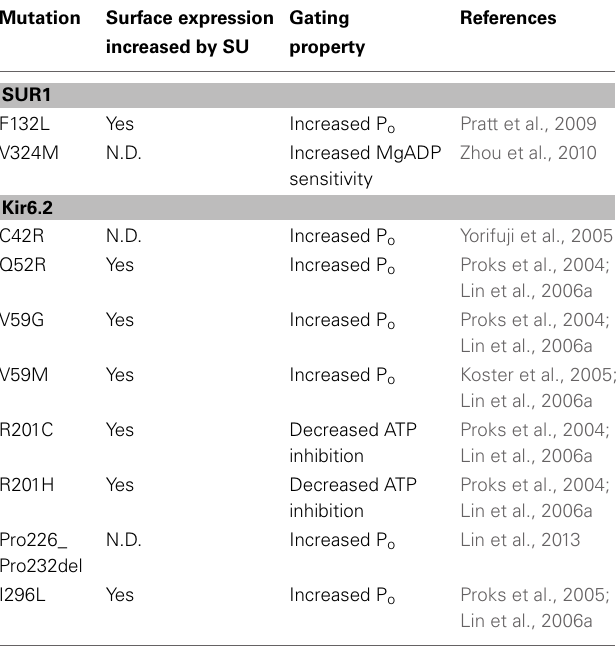
Table 2 | Neonatal Diabetes-associated K ATP channel trafficking mutations and response to sulfonylurea